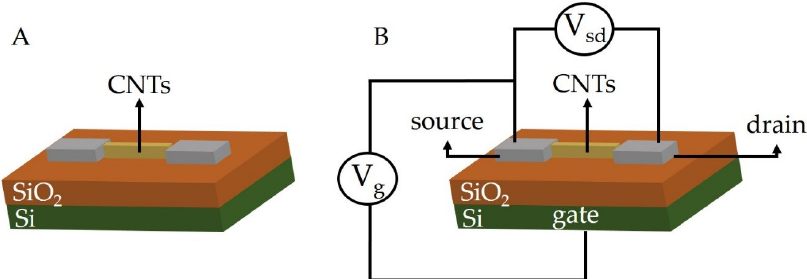
Figure 2. ( A ) Schematic chemiresistors and ( B ) ChemFET with carbon nanotubes as active material. V g is the gate bias potential and V sd is the source-drain potential.